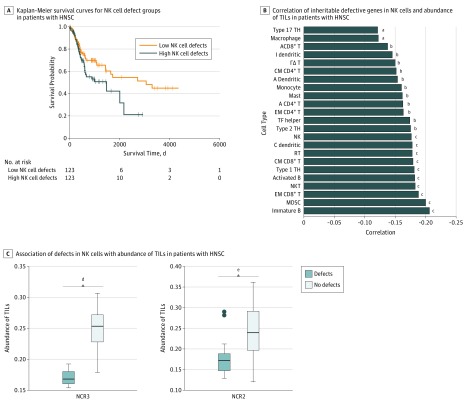
Association of Natural Killer (NK) Cells With Defective Genes With Tumor Immune Microenvironment Subtypes and Clinical OutcomesA, Representative Kaplan-Meier survival curve of the high-NKD gene patient group and low-NKD gene patient group in head and neck squamous cell carcinoma (HNSC). The curves for other cancer types are shown in eFigure 10 in the Supplement. B, Negative correlations between the number of inheritable defective genes in NK cells and the abundance of the tumor-infiltrating lymphocyte in tumor microenvironments for HNSC. The correlations for other cancer types are shown in eFigure 11 in the Supplement. C, Examples in HNSC showing that the abundance of tumor-infiltrating lymphocyte–NK cells was significantly lower in tumors bearing a defective gene in NK cells than the rest of the tumors. More examples are shown in eFigure 14 in the Supplement. Center horizontal line indicates mean; top and bottom borders of box, SD; whiskers, 95% CI; and circles, outliers. A indicates activated; B, B cell; cDC, conventional dendritic cell; CM, central memory; EM, effector memory; I, immature; MDSC, myeloid-derived suppressor cell; RT, regulatory T cell; T, T cell; TH, T helper cell; and TF helper, T follicular helper cell.aP < .10.bP < .05.cP < .001.dP = 2.12 × 10−3.eP = 4.81 × 10−3.